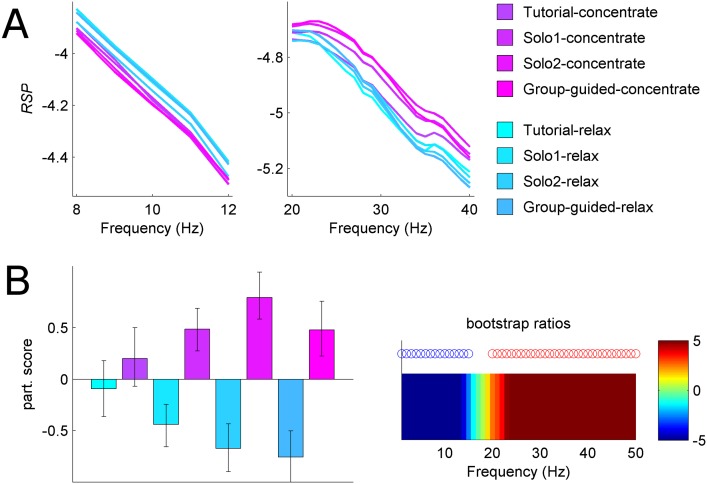
Relaxation vs. concentration states (example left frontal channel).
(A) Mean RSP curves across 8 guided conditions in alpha and beta frequency ranges. (B) Left: mean participant scores with respect to the main effect of relaxation vs. concentration across 1–50 Hz frequency range. Error bars indicate 95% confidence intervals (CI) Right: frequency pattern associated with the main effect. Frequencies with reliable positive (negative) bootstrap ratios exhibited greater (lower) RSP for concentration conditions compared to relaxation conditions and are indicated by red (blue) circles. As hypothesized, concentrate conditions showed more power in beta range and less power in alpha range, compared to relax conditions.